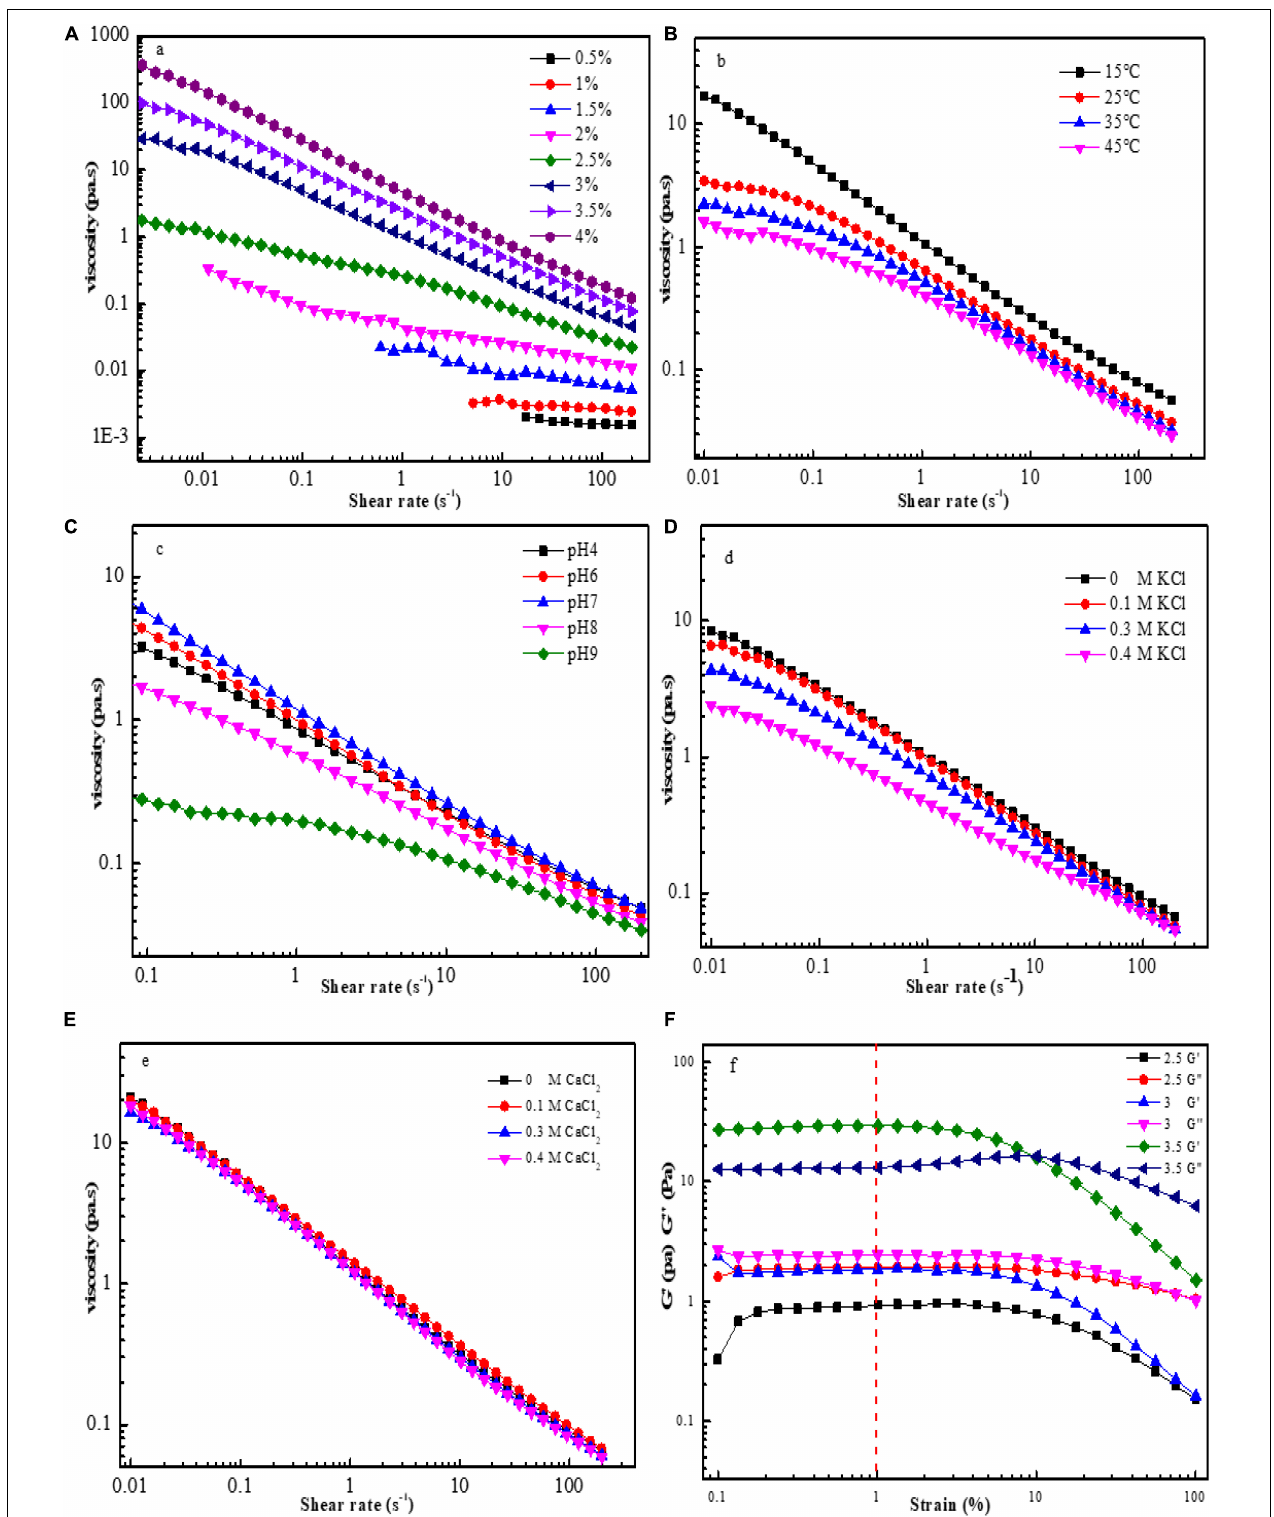
FIGURE 6 | Flow curves for EPS-F2 samples at various conditions: Effect of concentrations on apparent viscosity of EPS-F2 (A) ; Effect of temperature on apparent viscosity of EPS-F2 (B) ; Effect of pH on apparent viscosity of EPS-F2 (C) ; Effect of K + on apparent viscosity of EPS-F2 (D) ; Effect of Ca 2 + on apparent viscosity of EPS-F2 (E) ; The linear viscoelastic region curves of EPS-F2 (F) .